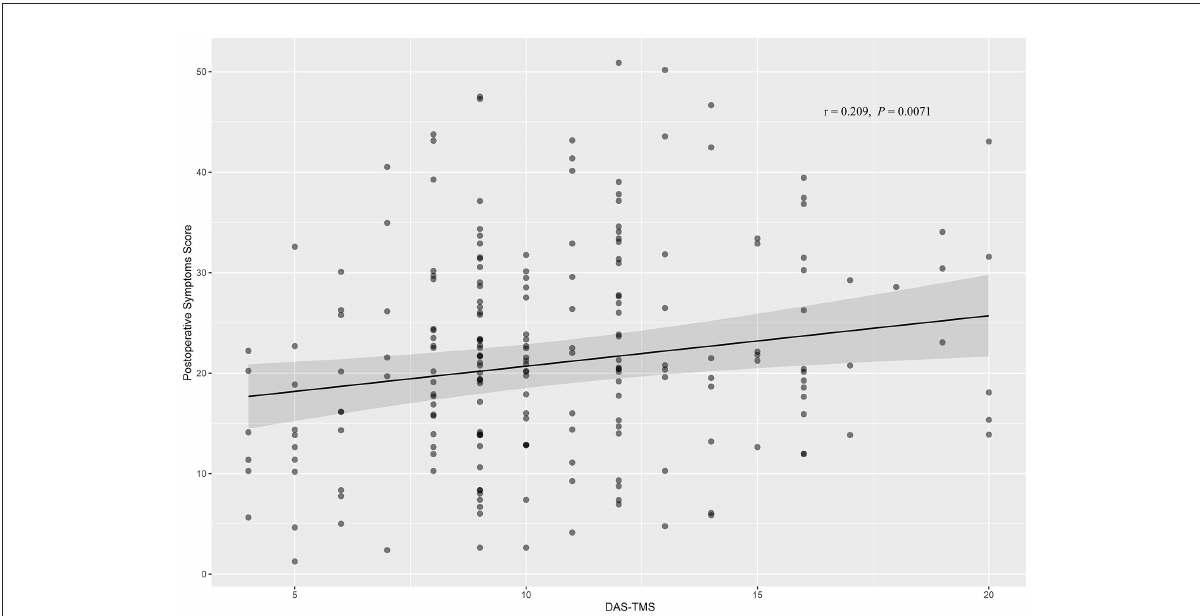
FIGURE2 Correlation between DAS-TMS and postoperative symptoms by Pearson’s test. DAS-TMS showed slightly positive correlation with postoperative symptoms ( r = 0.209, P =